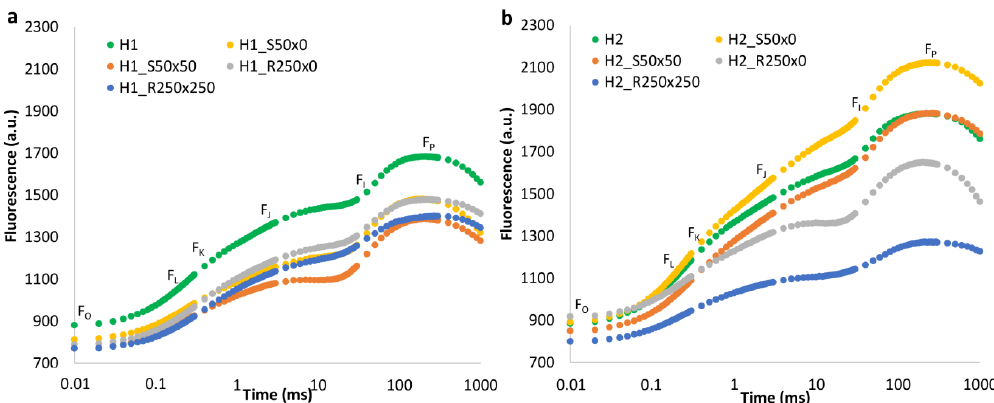
Figure 3. OLKJIP polyphasic fluorescence rise of plants grown in H1 ( a ) and H2 ( b ) supplemented by Stimpo and Regoplant calculated as mean value and plotted on a logarithmic time scale. Marks in graph refer to values used for calculation of certain parameters (Appendix A).